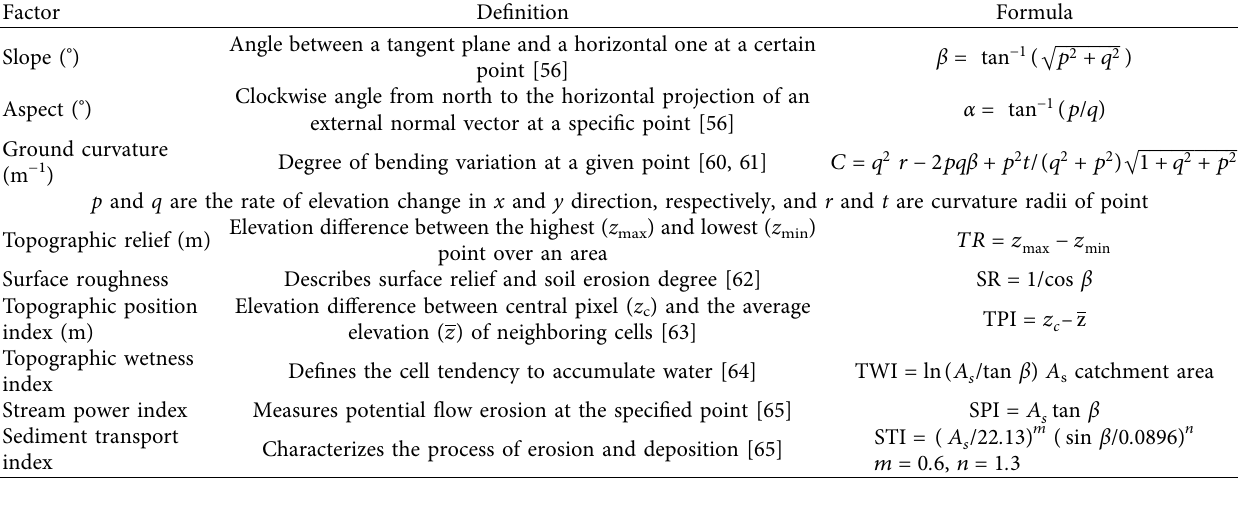
Table 1: Definition and formula of terrain